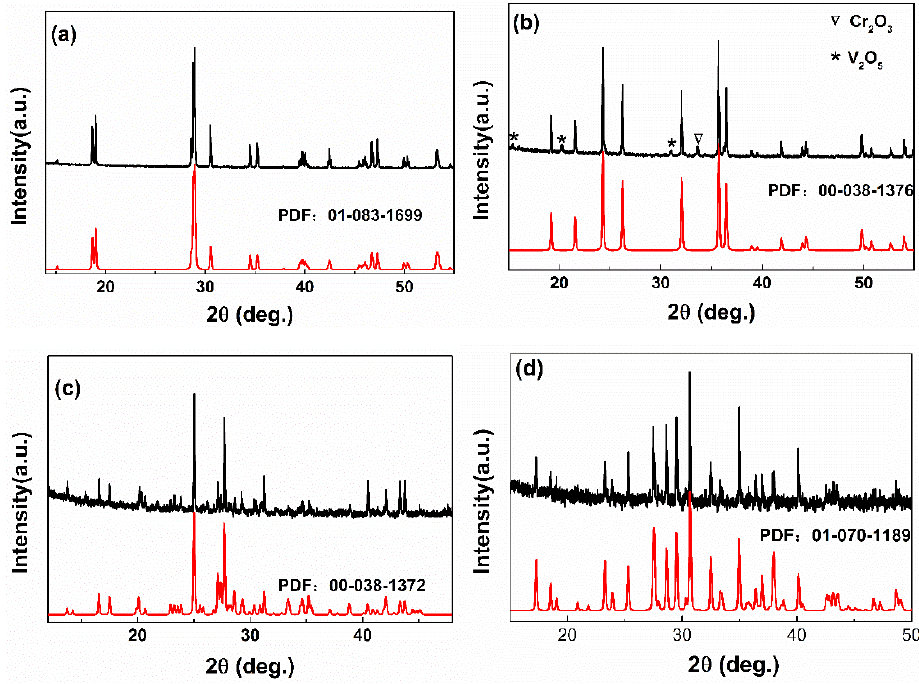
Figure 1. X-ray diffraction pattern of ( a ) BiVO 4 , ( b ) CrVO 4 , ( c ) FeVO 4 , and ( d ) Co 2 V 2 O